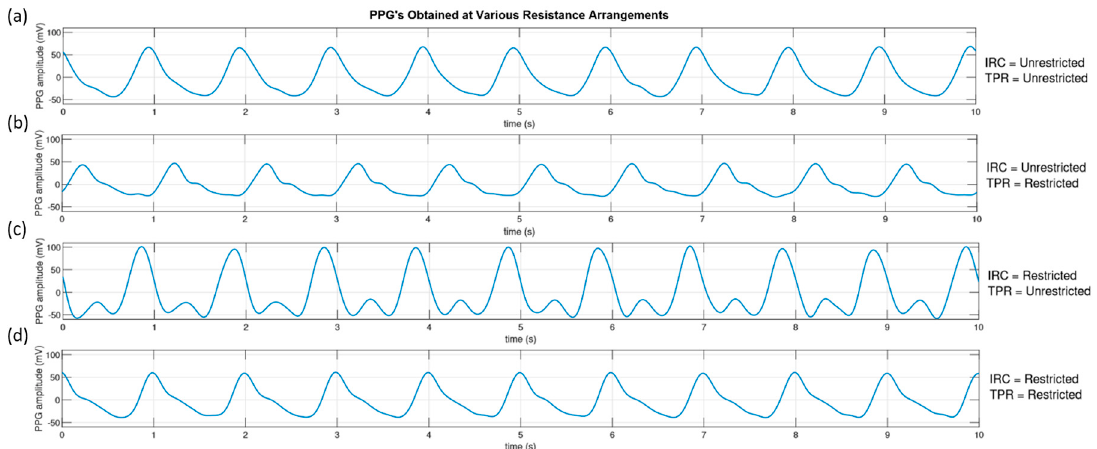
Figure 7. The analogue feedback from the driving waveform ( a ), from the linear driver and the pressure waves in the system at three locations; the compliance chamber (P1)( b ), pre-phantom (P2)( c ) and post-phantom (P3)( d ).